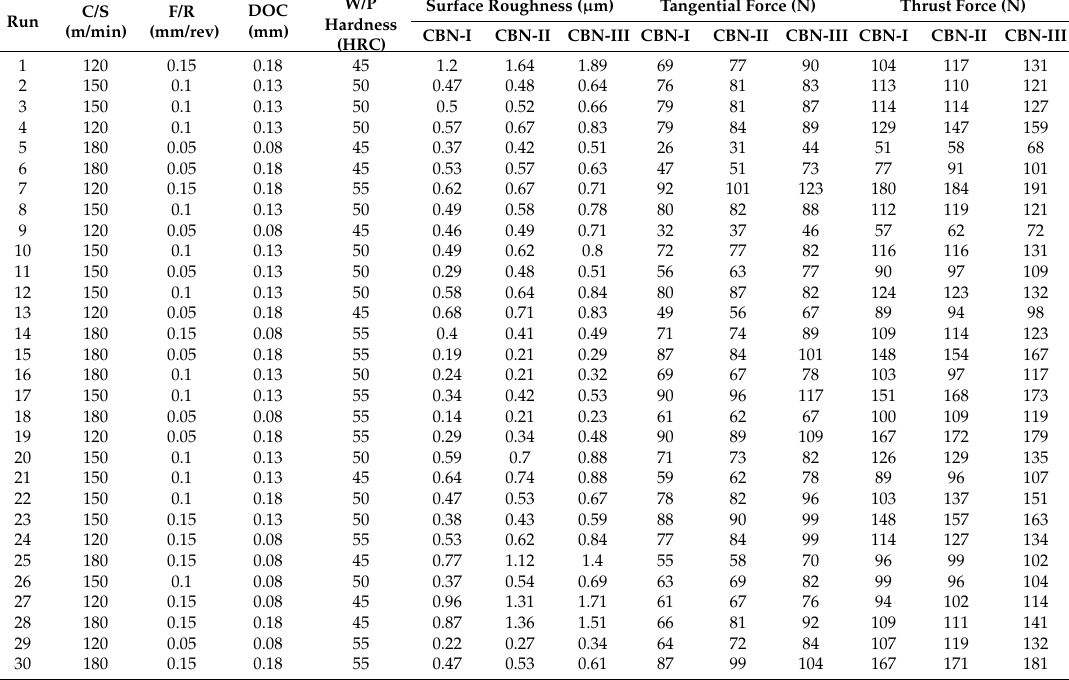
Table 3. Machining Parameters and their Levels.